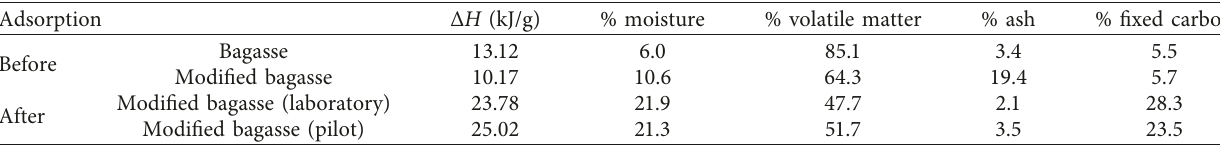
Figure 14: FTIR spectra of (a) modified bagasse, (b) CFW, and (c) modified bagasse after Table 7: Heat of combustion and proximate analysis.